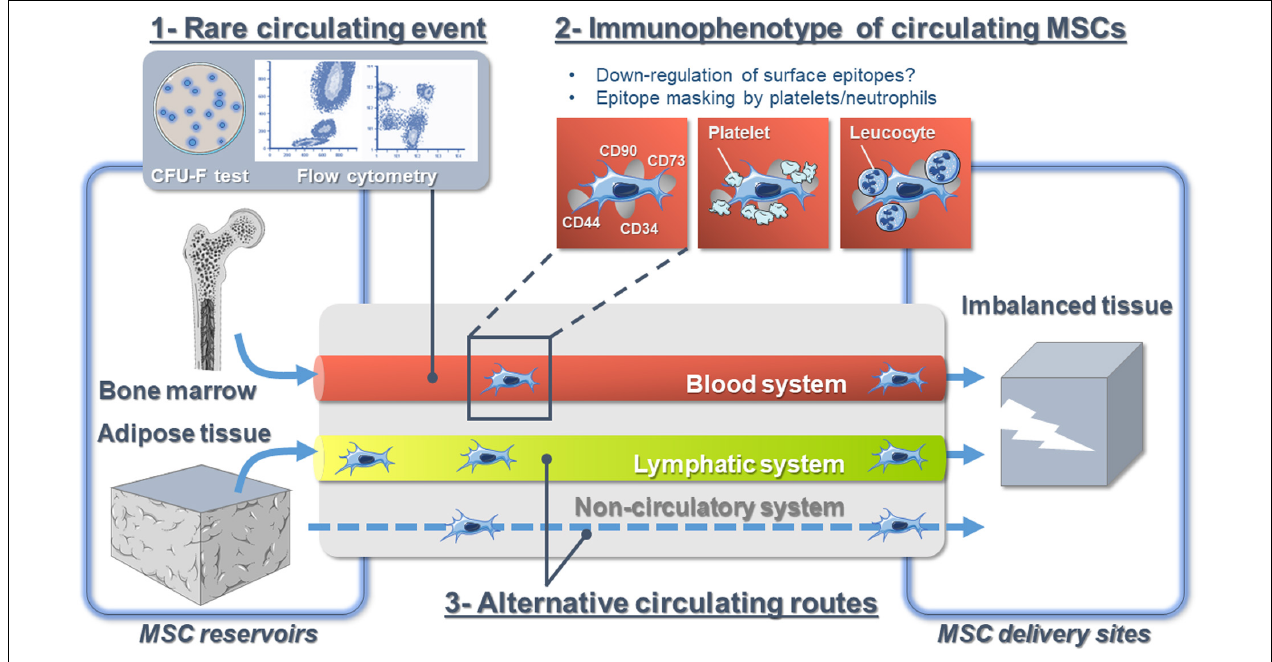
FIGURE 1 | The hypotheses explaining the controversy over endogenous mesenchymal stromal cell circulation in vivo